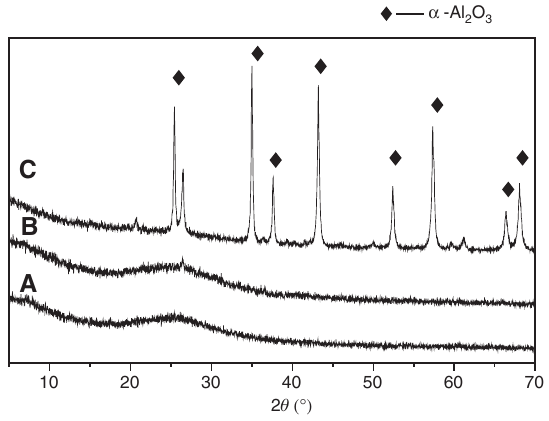
Figure 1: XRD patterns of glass samples with or without ball milling. (A) Before ball milling, (B) milling with PU balls, and (C) milling with alumina